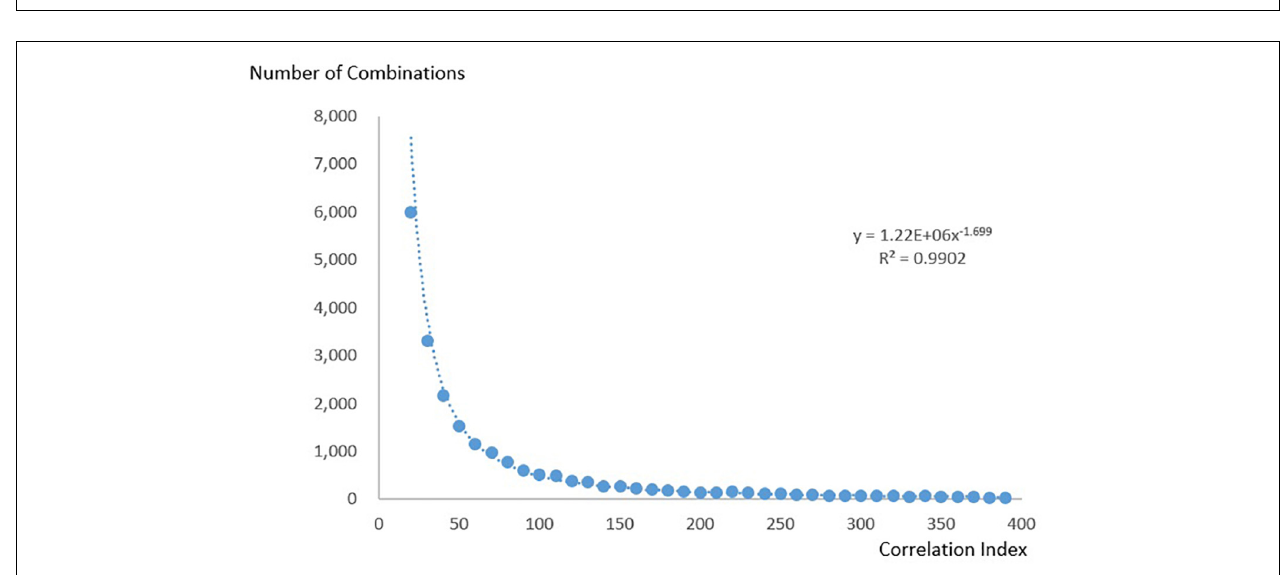
FIGURE 7 | Correlation index of the 20 most commonly used combinations.